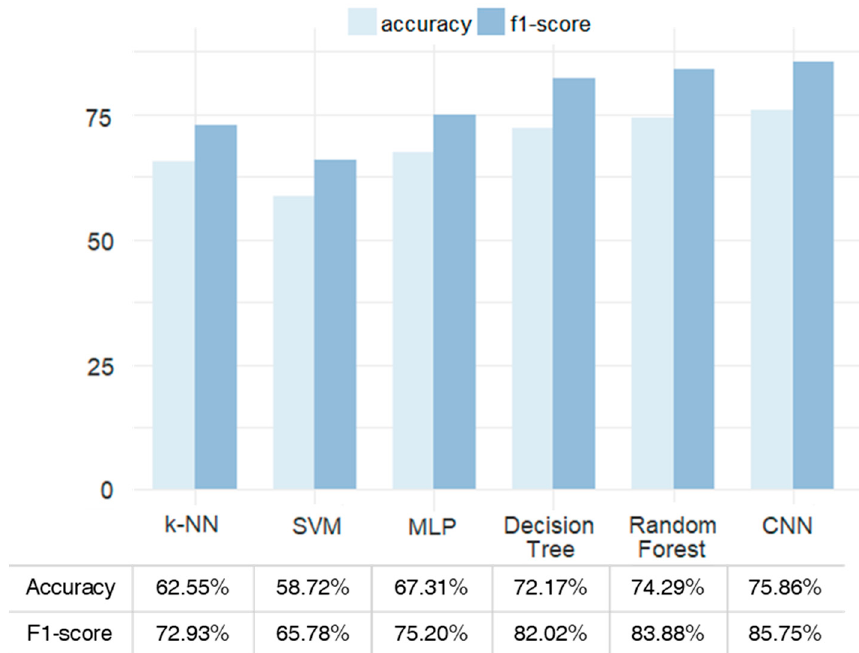
Figure 3. Comparison of our method with machine learning models.